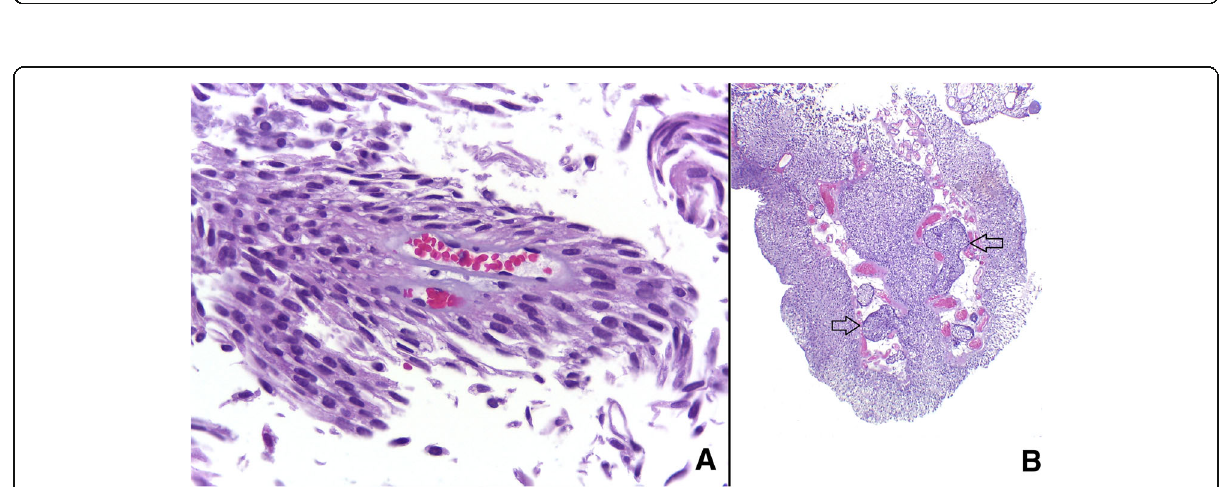
Fig. 3 Papillary urothelial lesion immunostained for phosS6 (Ser 235/236), 40x. This protein serves as a surrogate for mTOR activation. Its expression is shown in superficial well differentiated cells of a papillary neoplastic